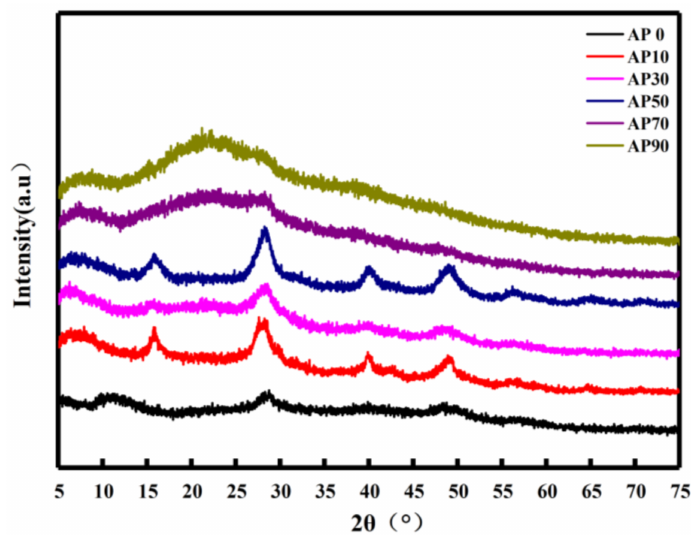
Figure 4. XRD pattern of starch-based